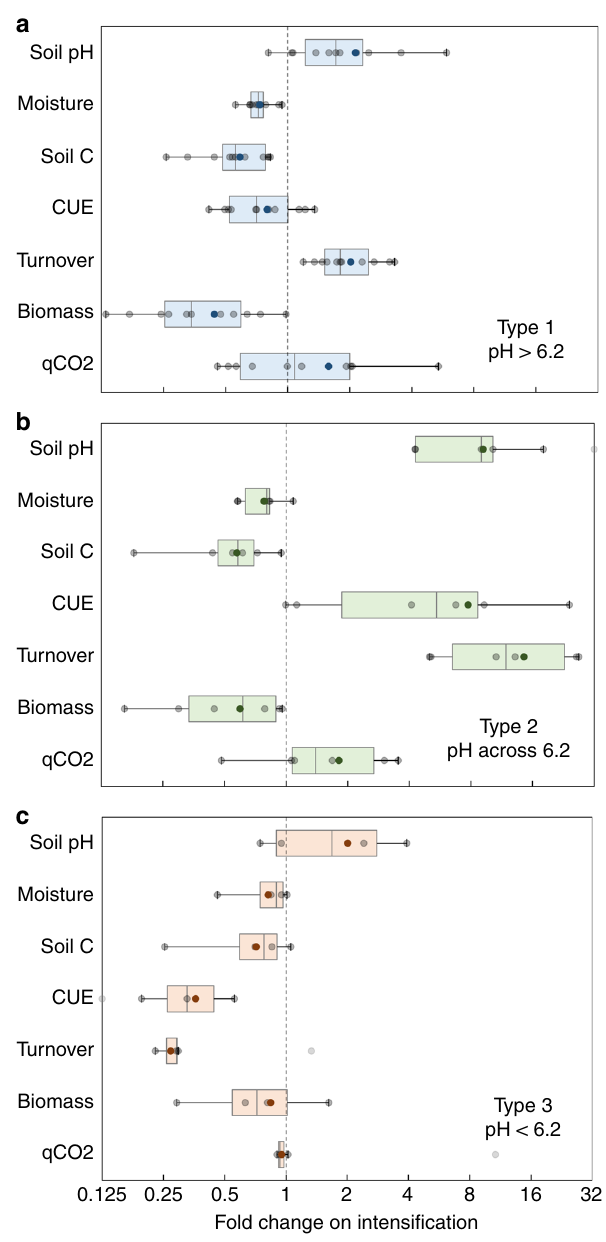
Fig. 4 Land use impact on edaphic properties and microbial traits. Fold change of various edaphic properties and microbial physiological traits in the hypothesized categories of effects of land use intensi fi cation. Displayed here is the fold change in the measured parameter on land use intensi fi cation for 21 comparable local land use contrasts (no. of contrasts — type 1 ( a ): 11, type 2 ( b ): 6, and type 3 ( c ): 4; Table 1) that was calculated as the ratio of mean parameter values from low and high intensity treatments with three replicates each. Gray points represent means of fold change for each contrast, colored points represent the means across all contrasts, medians are marked by the vertical line inside the box, boxplots show quartile values for each parameter, and the whiskers extend to the highest and lowest values across all contrasts. Dotted line is the boundary indicating identical parameter values across the land use